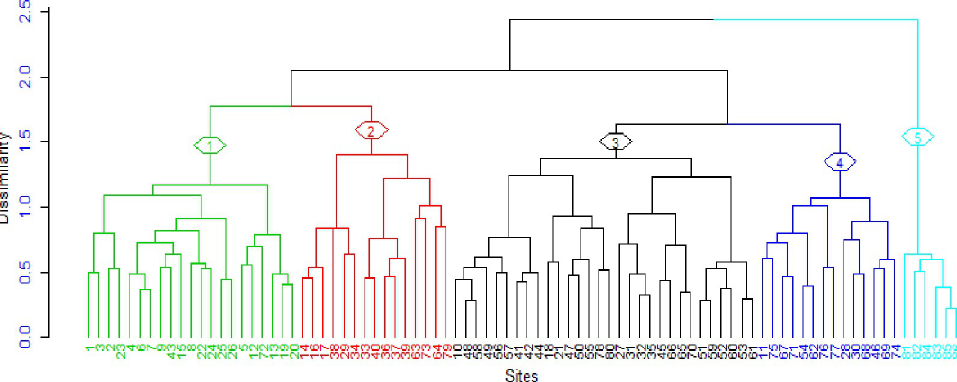
Fig 3. Dendrogram of the vegetation data obtained from hierarchical cluster analysis of the study area (l = Community type 1, 2 = Community type 2, 3 = Community type 3, 4 = Community type 4 and 5 = Community type